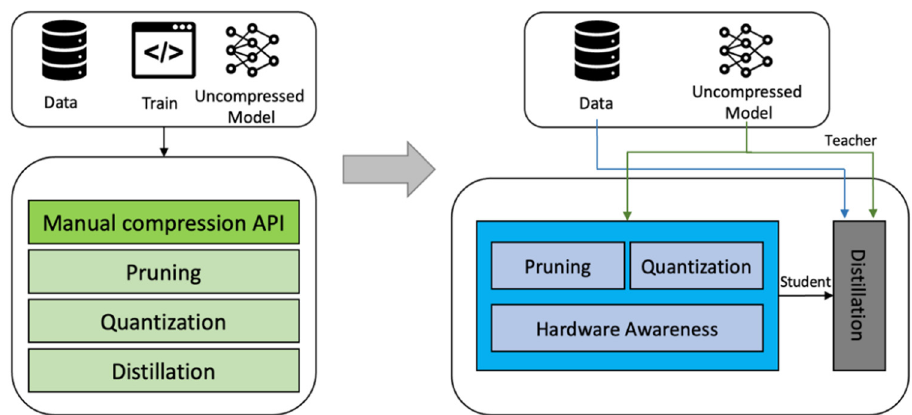
Figure 5. Automatic compression model method flow.